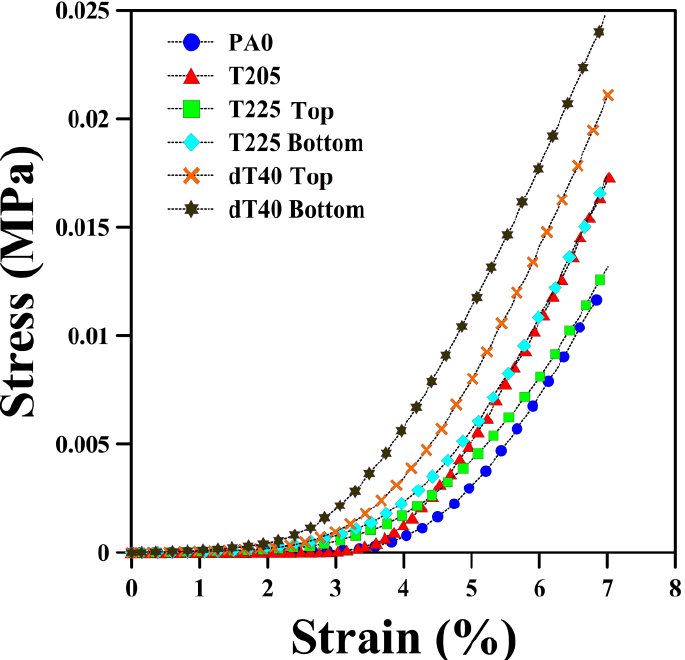
Figure 4. Compressive stress – strain curves of unfoamed (PA0), uniform (T205) and graded POE foams (top and bottom sides of T225 and dT40).